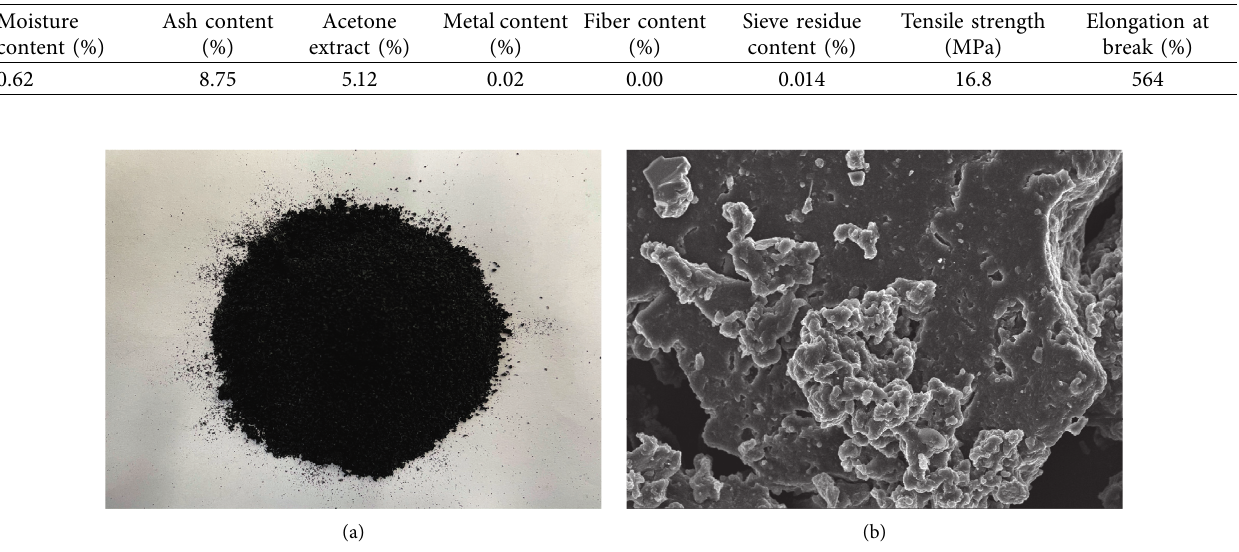
Table 2: Technical indexes of rubber particle.